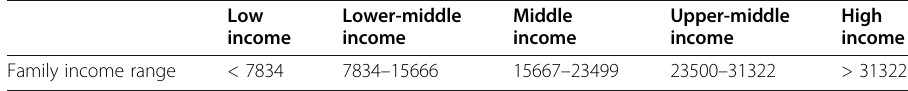
Table 1 The category of total monthly family incomes (unit: RMB yuan) Low